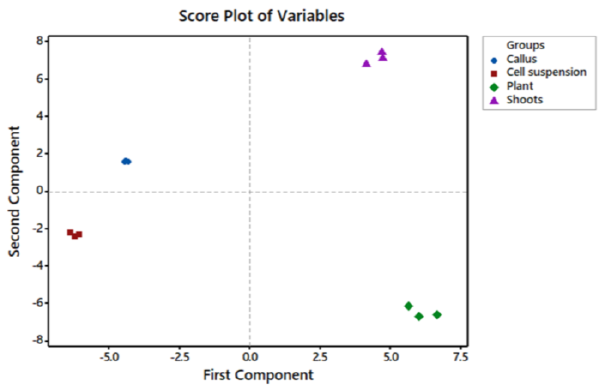
Figure 1. Score plot of the first two principal components identified by principal component analysis (PCA) of GC/MS identified metabolites in G. jasminoides plant leaves (green) and in vitro grown shoots (purple), callus (blue), and cell suspension (red) cultures.